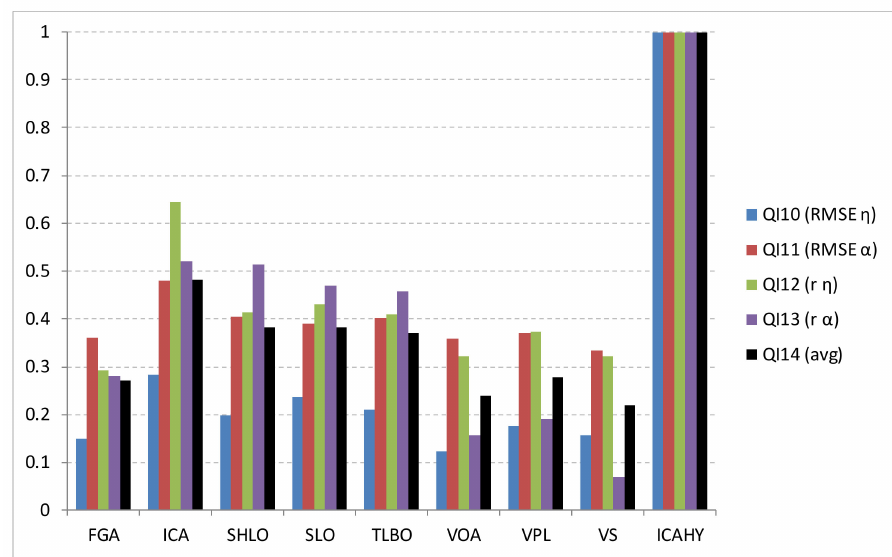
Figure 12. Relative quality of ICAHY results compared with the results of the other algorithms under